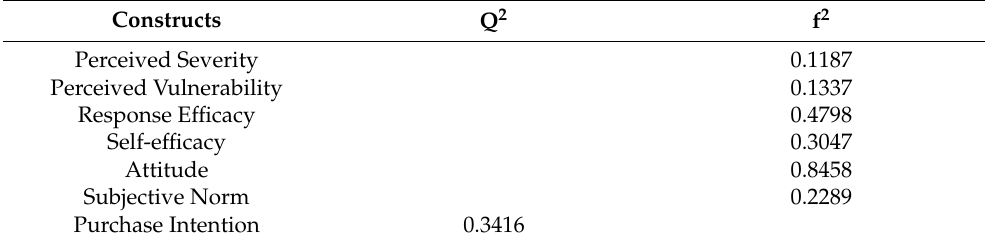
Table 6. Values of the Indicators of Predictive Relevance (Q 2 ) and Effect Size (f 2 ).